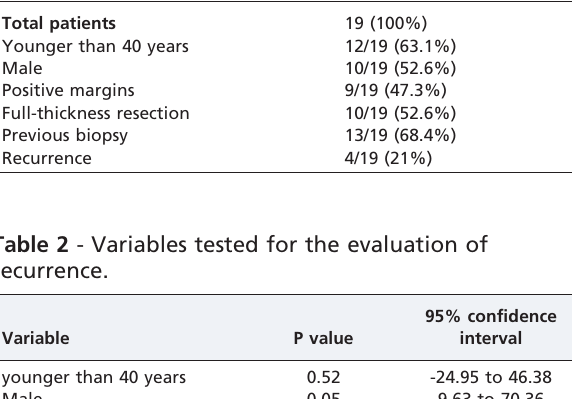
Table 1 - Descriptive characteristics of the patients.